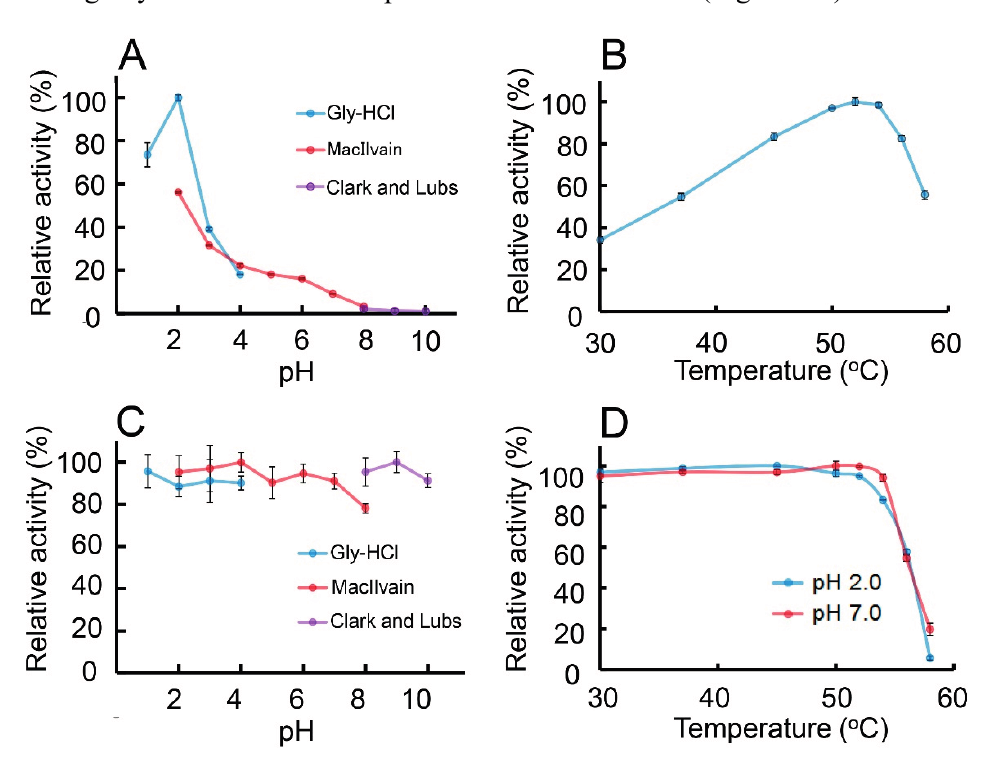
Figure 3. Characterization of the chitinolytic activity of E. coli -expressed Protein A-CatD-V5-His. ( A ) pH profile; ( B ) temperature profile; ( C ) pH stability profile and ( D ) thermostability profile of the chitinase activity for recombinant CatD were